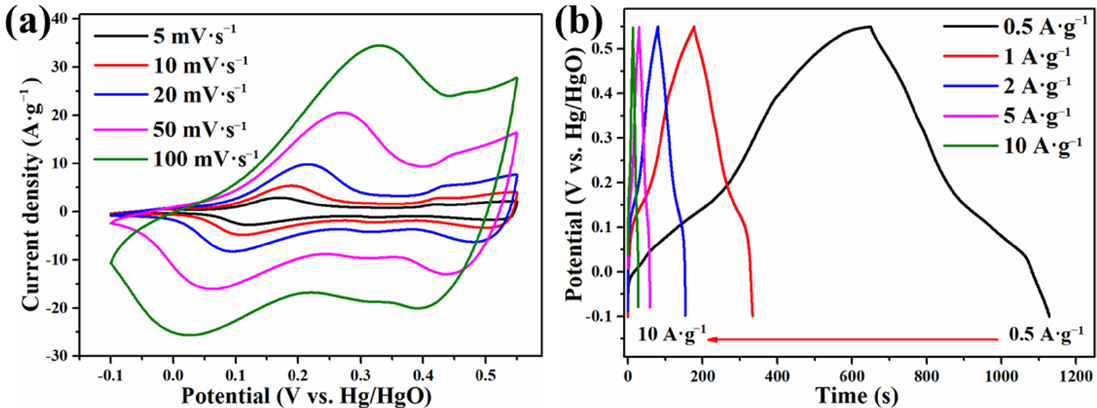
Figure 5. ( a ) CV curves of PCoSi; ( b ) GCD curves of PCoSi.